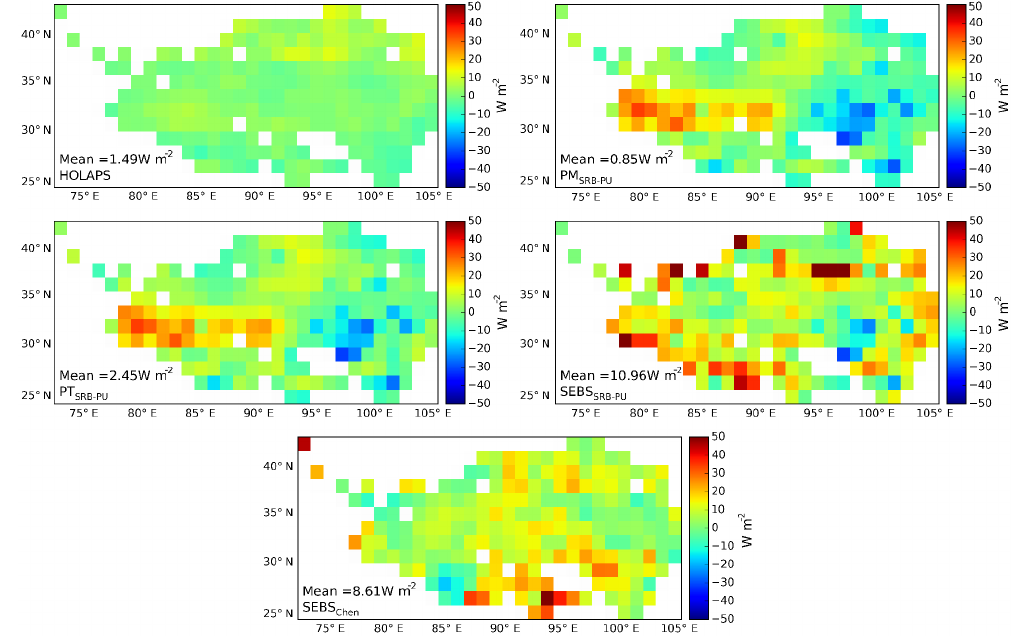
Figure 5. Differences of spatial distribution of annual mean LE between LandFlux-EVAL and other datasets over the TP.